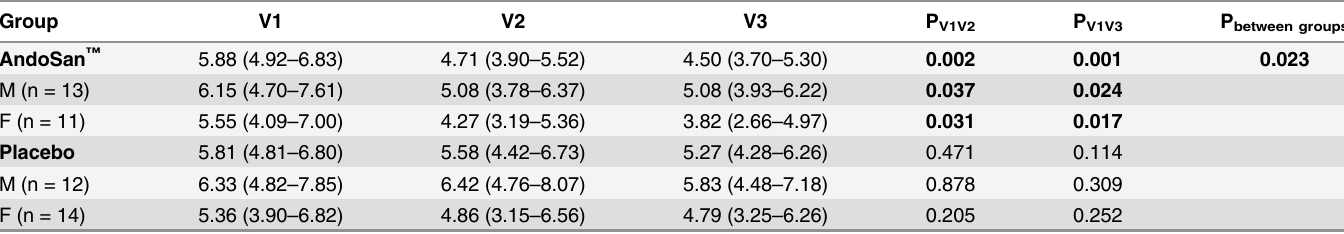
Table 2. Symptom score for the UC patients.